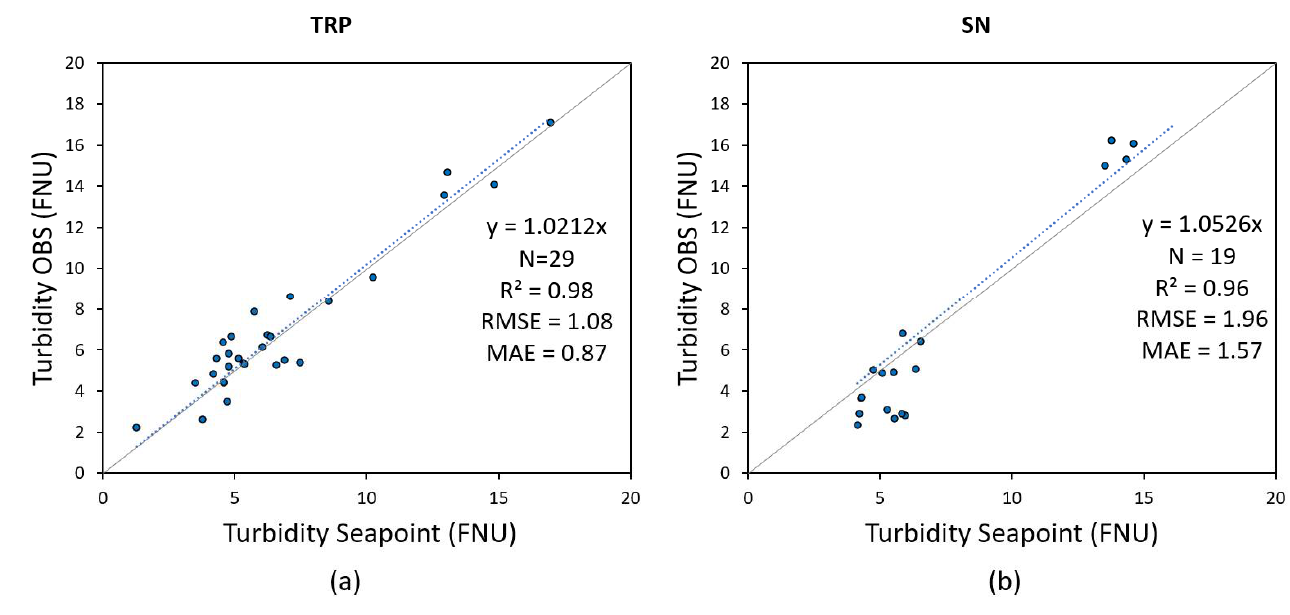
Figure 2. Scatter plot of the turbidity data retrieved from the fixed stations (OBS) compared with the data from CTD probe profiles (Seapoint) at TRP ( a ) and SN ( b ). The linear regression equation and the common descriptive statistical metrics are reported in the plots: number of data pairs (N); coefficient of determination (R 2 ); root mean square error (RMSE); and mean absolute error (MAE). Dotted lines are the best-fit regression, forced through zero. Grey solid line is the 1:1 line.